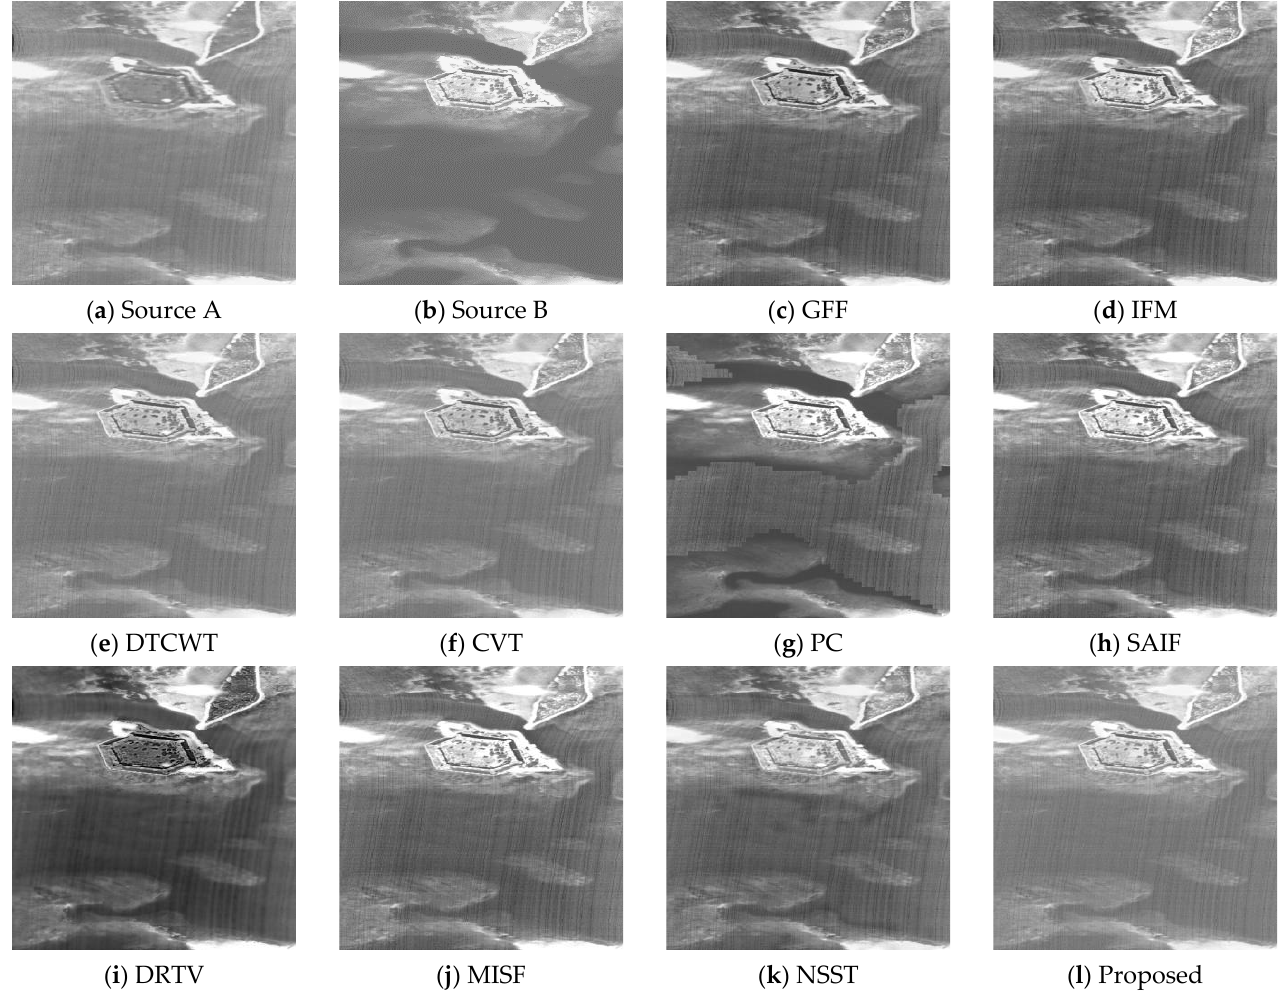
Figure 7. Fusion results of the fourth group of images. ( a ) Source A, ( b ) Source B, ( c ) GFF, ( d ) IFM, ( e ) DTCWT, ( f ) CVT, ( g ) PC, ( h ) SAIF, ( i ) DRTV, ( j ) MISF, ( k ) NSST, ( l ) proposed